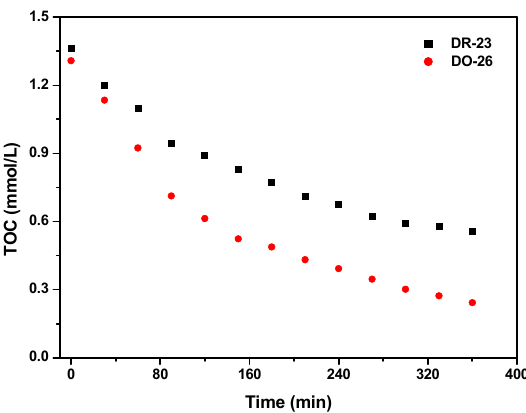
Figure 20. The change of TOC concentration during photocatalytic degradation of Direct Orange 26 and Direct Red 23 with BiGdO 3 as catalyst under visible light irradiation.